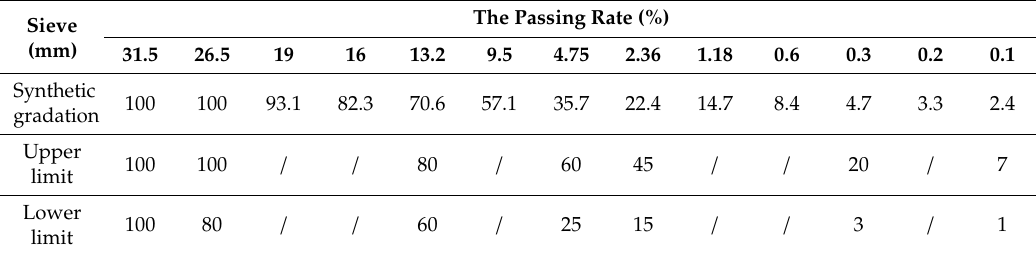
Table 2. Synthetic gradation of emulsified asphalt cold recycled mixture